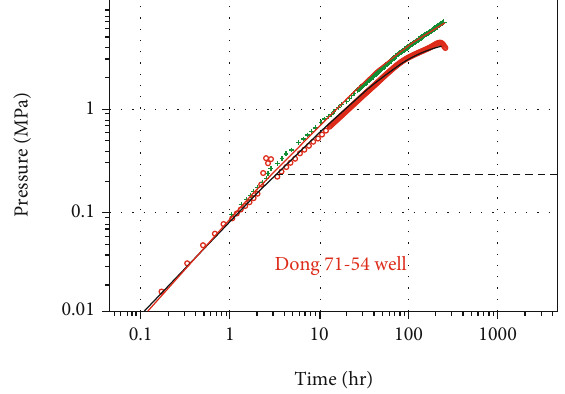
Figure 2: Characteristics of the well test curve in the middle stage of